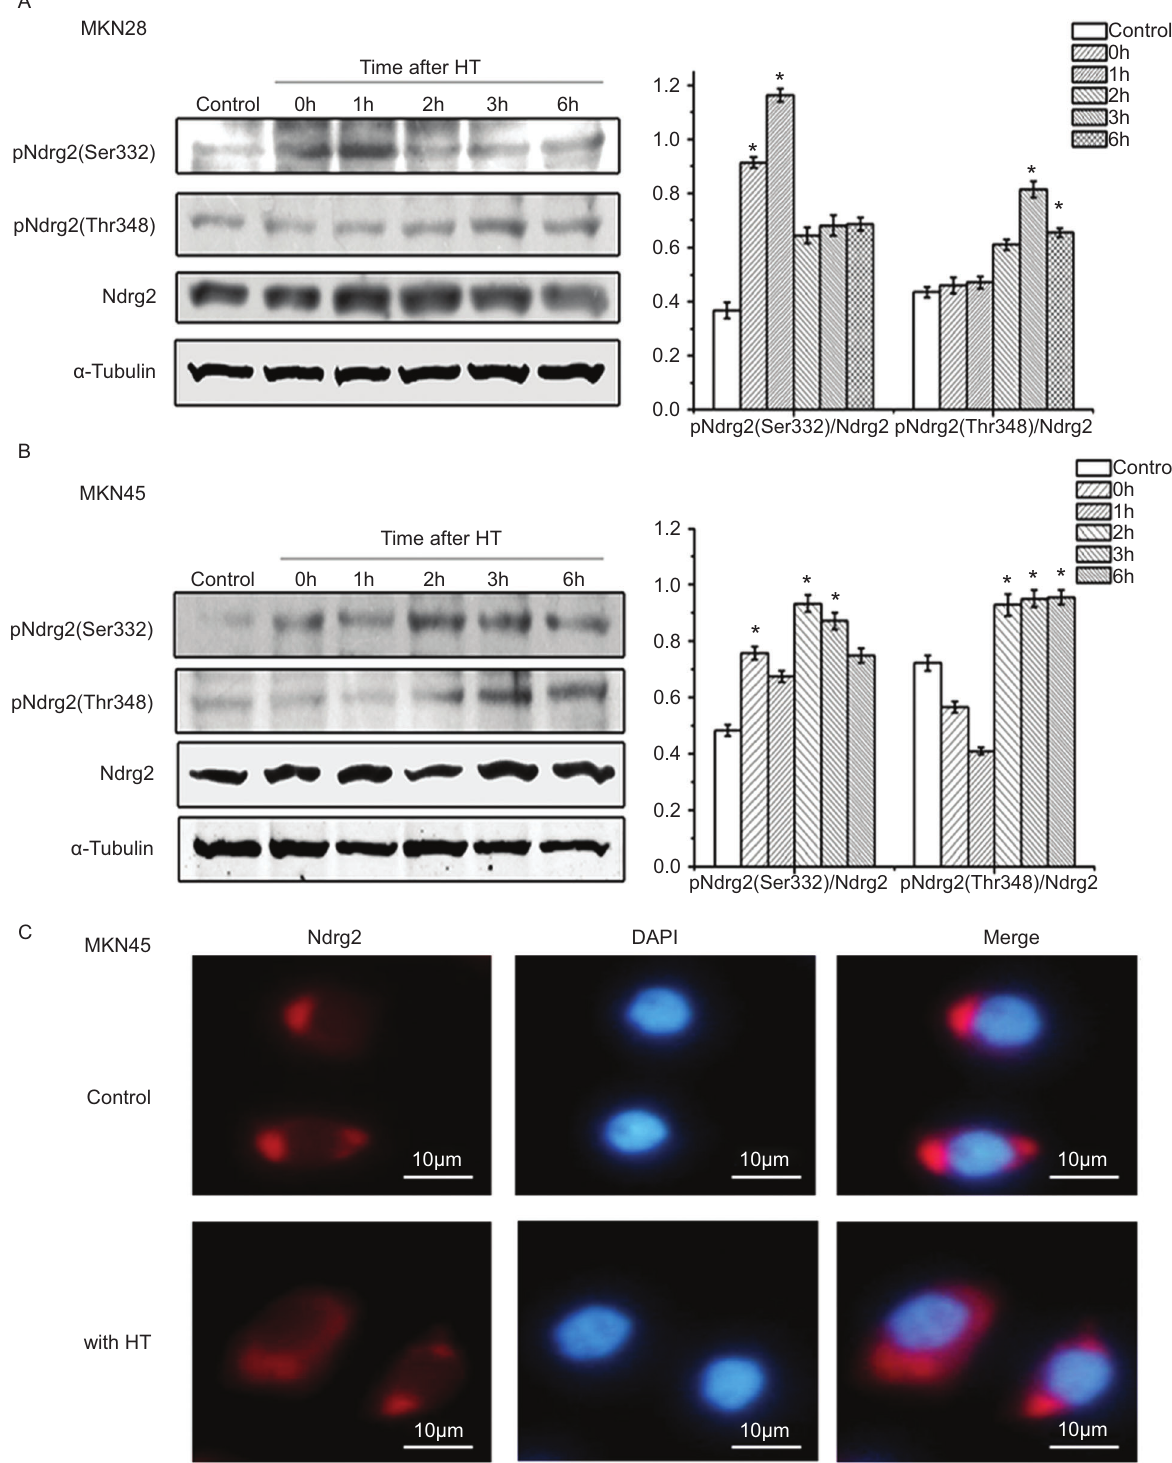
Figure 3. See legend on previous